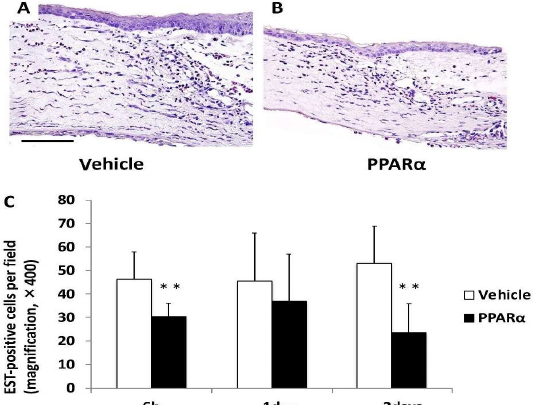
Figure 4. Infiltration of neutrophils in alkali-burned cornea. The number of infiltrating naphthol AS-D chloroacetate esterase (EST)-positive neutrophils ( C ) was significantly lower in the PPARα agonist group ( B ) than the vehicle group ( A ) at 6 h and on day 2 (** p < 0.01). Scale bar: 50 μm.